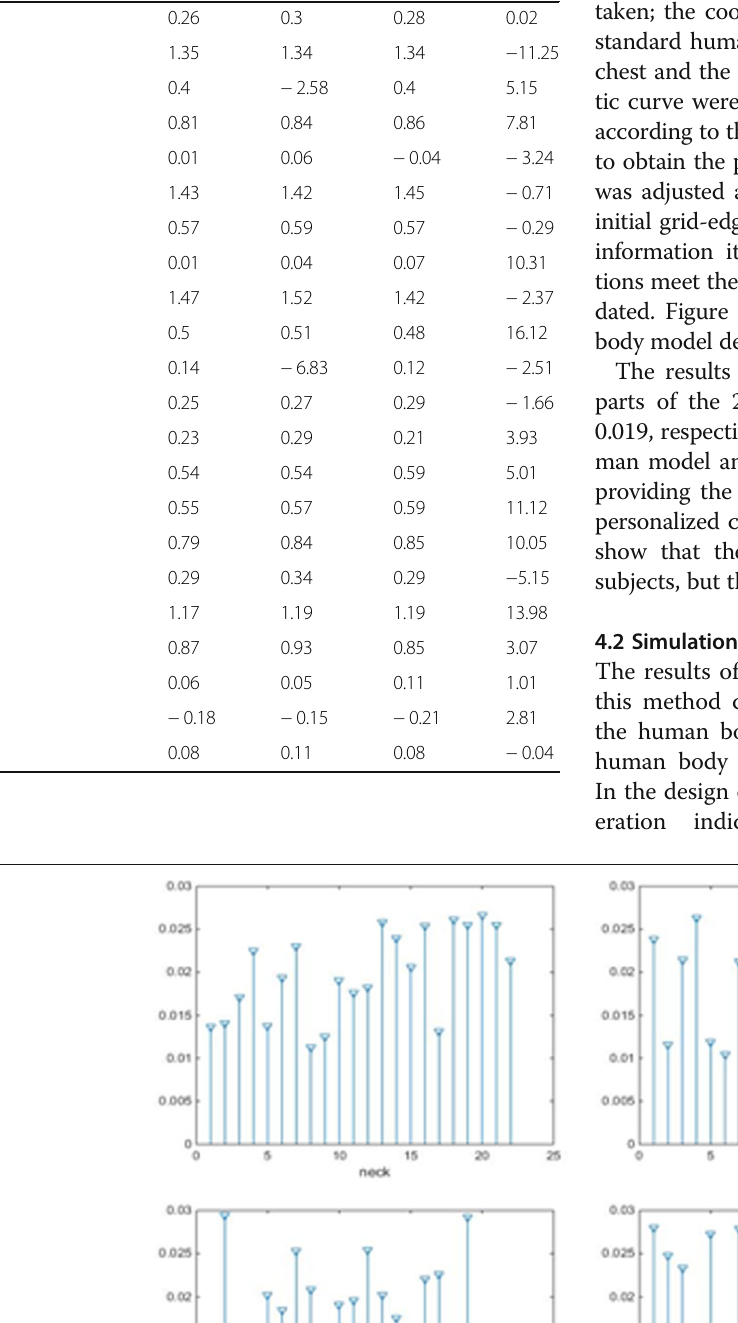
Table 1 Result of different input parameters Sample